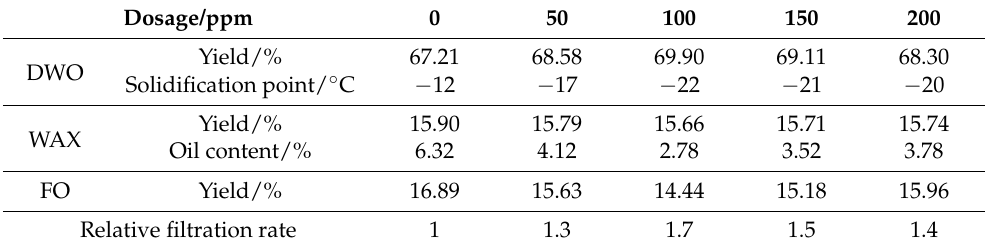
Table 7. MEK–toluene dewaxing with different dosages of